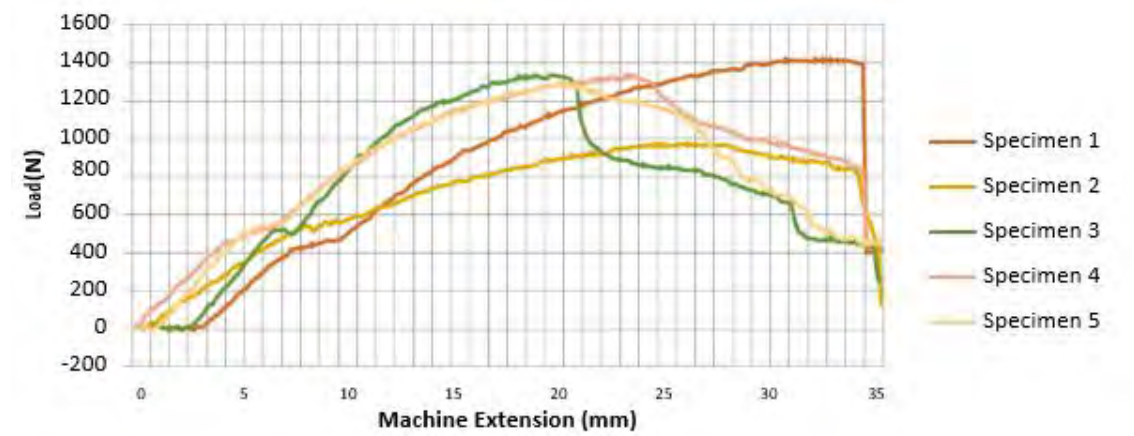
Figure 26. Load-Extension Curves of the 5 specimen in theApparent Modulus of Elasticity (Authors)